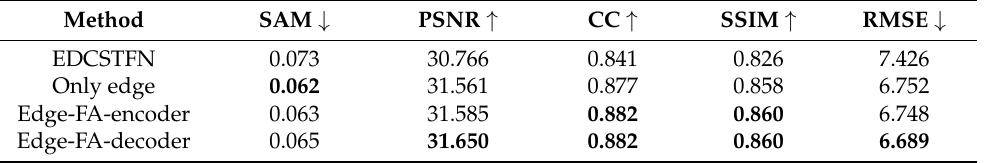
Table 5. Objective evaluation of the Daxing dataset in ablation